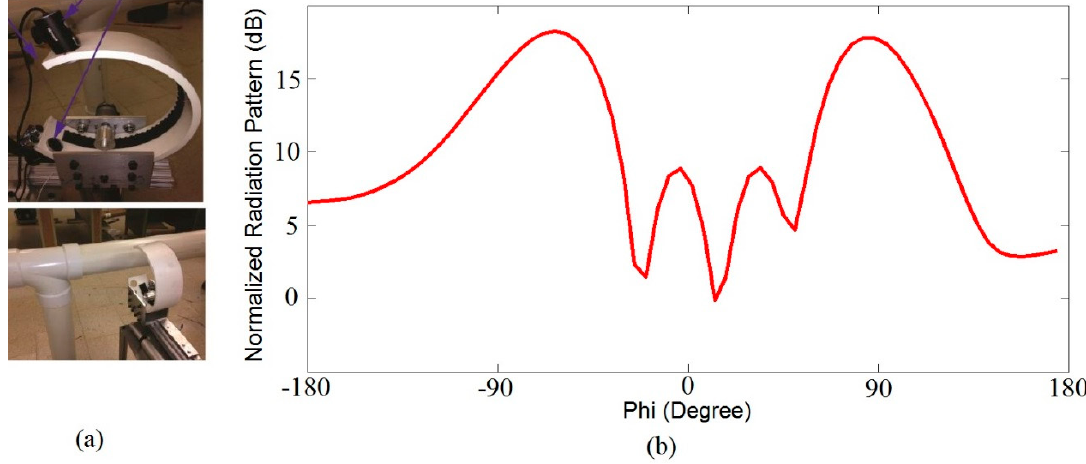
Figure 19. ( a ) C-arms of the robot where both antennas is placed; ( b ) Simulated normalized radiation pattern of two antennas when excited in opposite direction in case of target at freq. of 4 GHz.